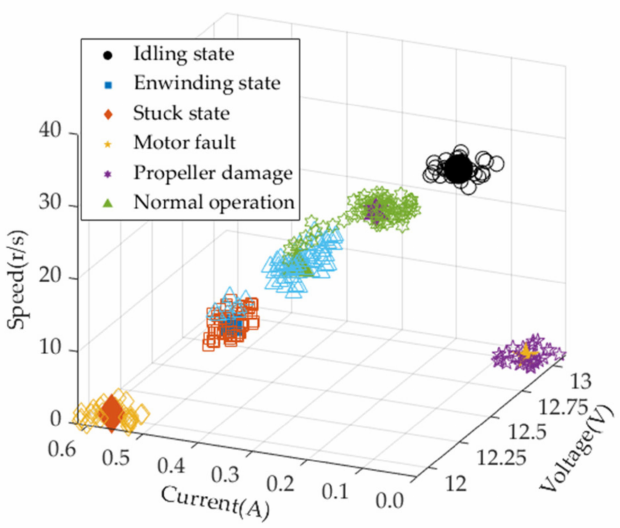
Figure 9. The classification results by the proposed PFCM